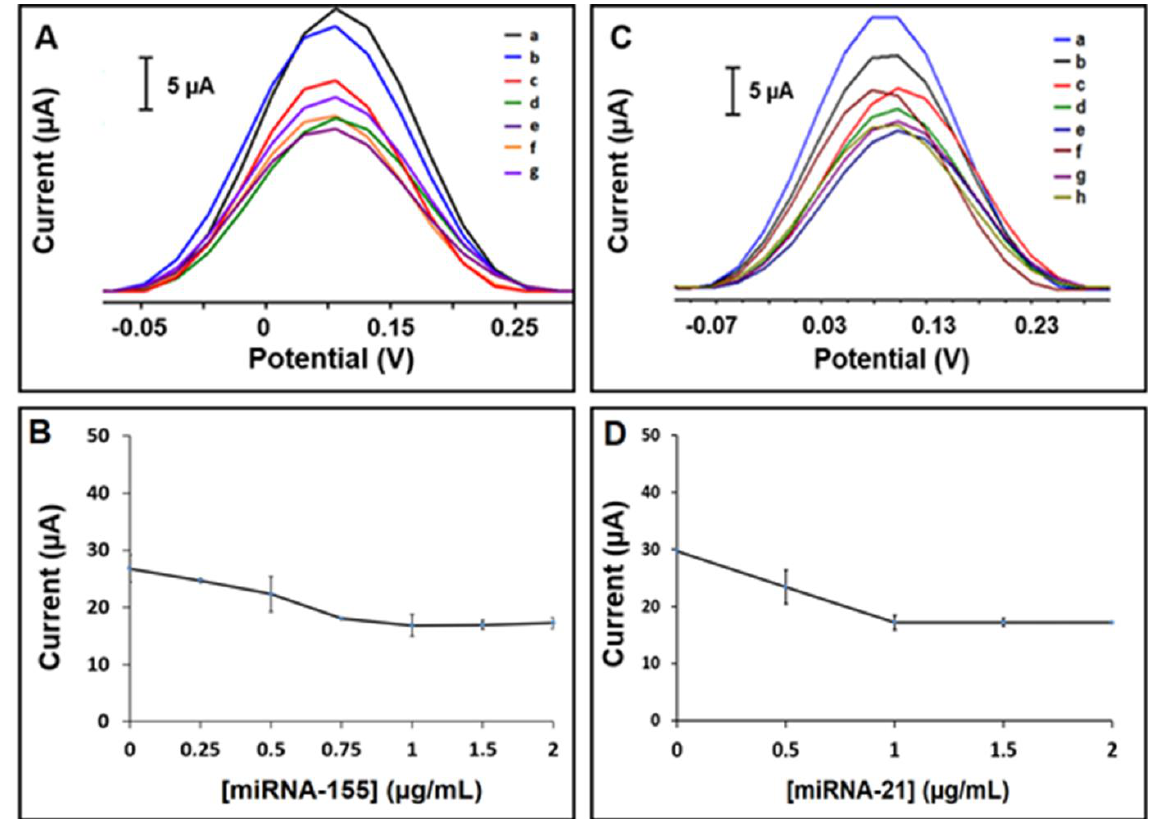
Figure 3. ( A ) Voltammograms representing the [Fe(CN) 6 ] 3−/4− oxidation signal obtained by (a) Probe-1 immobilized AuNP/RGO-paper electrode in the absence of miRNA-155 target, after hybridization of Probe-1 with miRNA-155 target at concentrations of (b) 0.25 µg/mL, (c) 0.5 µg/mL, (d) 0.75 µg/mL, (e) 1.0 µg/mL, (f) 1.5 µg/mL, and (g) 2.0 µg/mL. ( B ) The line graph based on the average [Fe(CN) 6 ] 3−/4− oxidation signal after hybridization between Probe-1 and miRNA-155 target with its various concentrations from 0 to 2.0 µg/mL ( n = 3). ( C ) Voltammograms representing the [Fe(CN) 6 ] 3−/4− oxidation signals obtained by (a) Probe-2 immobilized AuNP/RGO-paper electrode in the absence of miRNA-21 target, after hybridization of Probe-2 with miRNA-21 target at concentrations of (b) 0.25 µg/mL, (c) 0.5 µg/mL, (d) 0.75 µg/mL, (e) 1.0 µg/mL, (f) 1.5 µg/mL, and (g) 2.0 µg/mL. ( D ) The line graph based on the average [Fe(CN) 6 ] 3−/4− oxidation signal measured after hybridization between Probe-2 and miRNA-21 target with its various concentrations from 0 to 2.0 µ g/mL ( n =